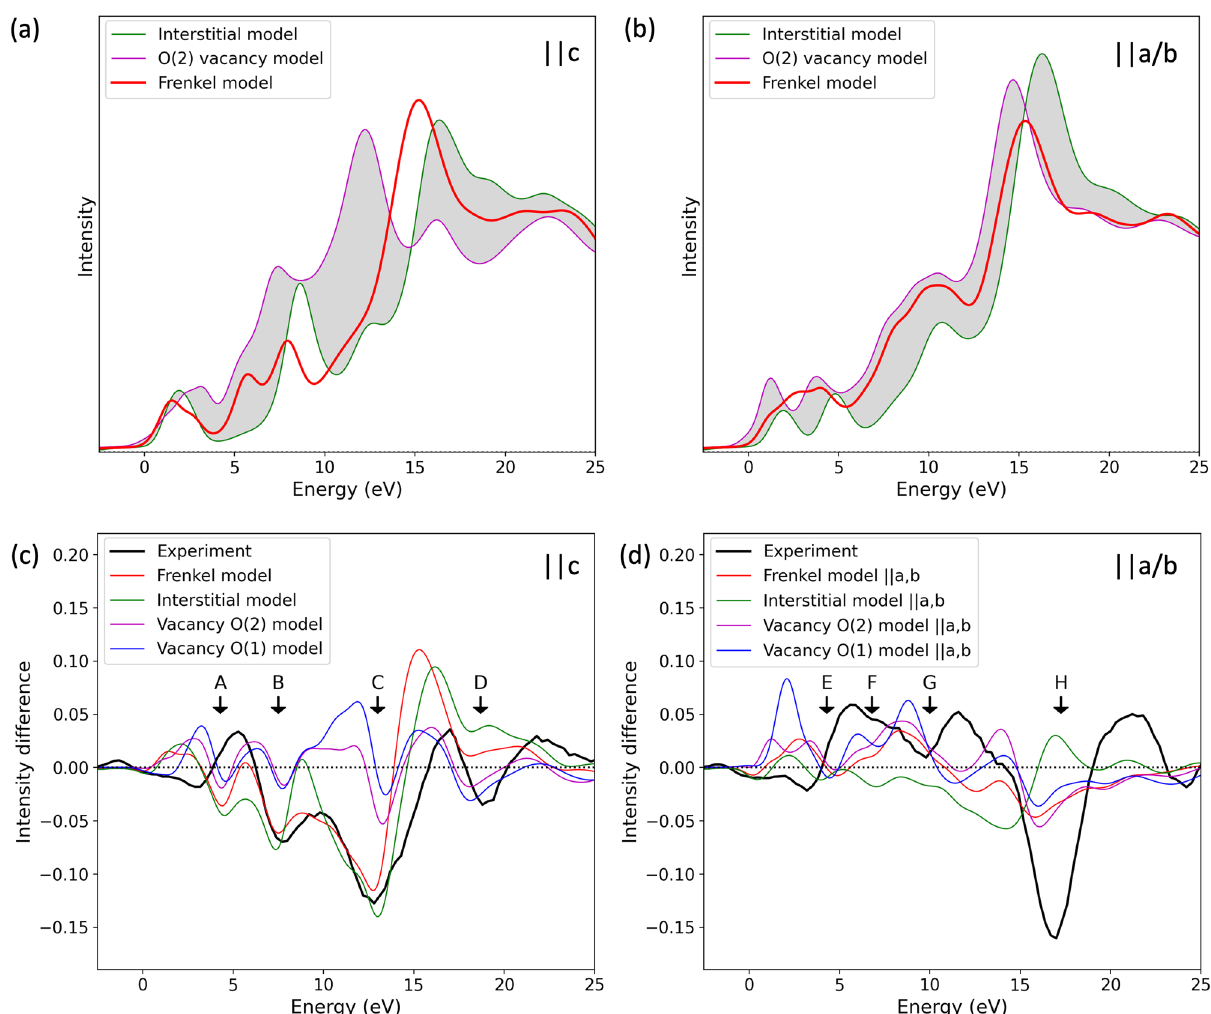
Fig. 7 Comparison of the Frenkel defect model with the constituent interstitial and vacancy defect models. a , b Comparison of linear combinations of spectra simulated from interstitial oxygen at site I and O(2) vacancy models with the Frenkel defect model ^ E jj c and ^ E jj a = b , respectively. c , d Difference spectra comparing 10 16 He + ions cm − 2 irradiated relative to pristine experimental data with various defect models compared with the pristine model, for ^ E jj c and ^ E jj a = b ,